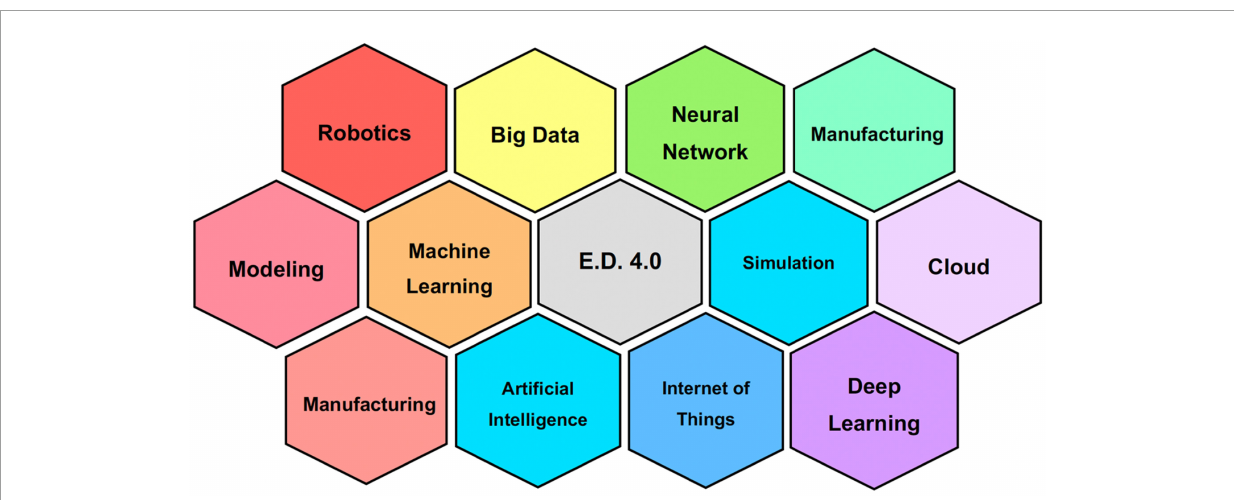
FIGURE10 Current components of E.D. 4.0, as identified by bibliometric analysis. These elements form the most updated markers of E.D. 4.0 and align closest with the current requirements of I.D. 4.0.